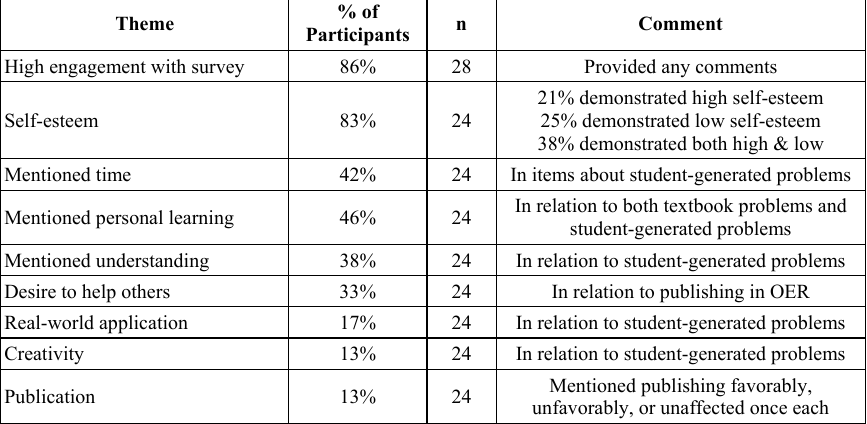
Table 3. Themes derived from qualitative